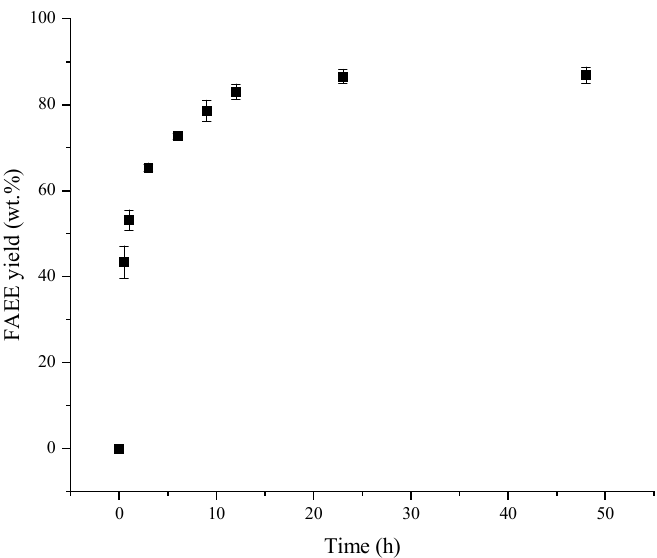
Figure 3. Profile of fatty acid ethyl ester (FAEE) yield (wt.%) vs. time for the esterification/transesterification of SODD saponifiable phase (SODD-SP) (15 g) with ethanol (8.10 g). Reactions conditions: up to 48 h reaction; 35 ◦ C; molar ratio of 3.64:1 (ethanol:SODD-SP) and 8.36 wt.% enzyme concentration.